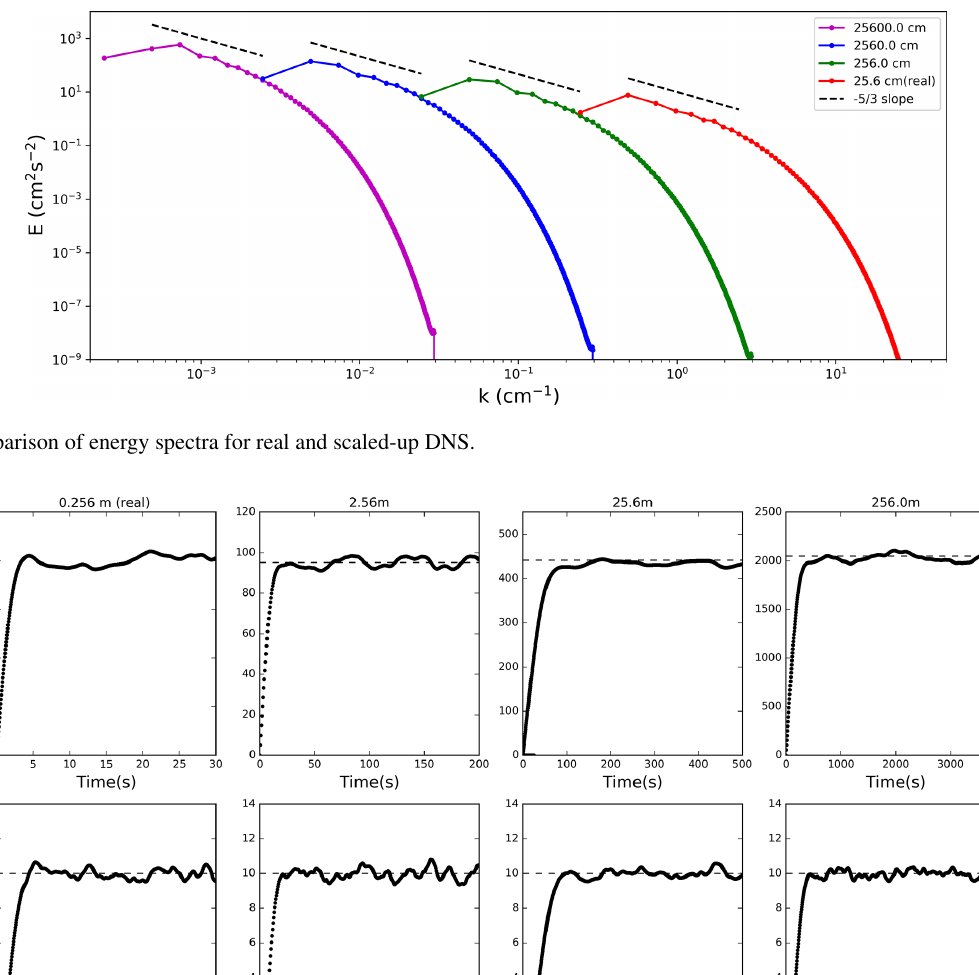
4 Applying super-droplets for the scaled-up